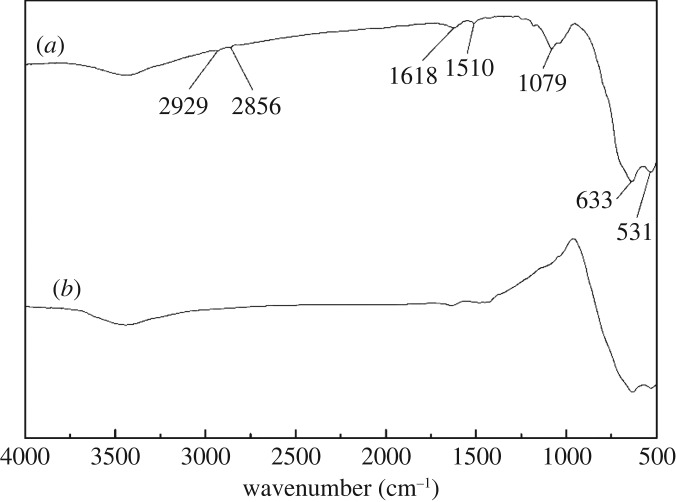
Effect of Fe3+ on the adsorption of OHA on cassiterite: (a) cassiterite conditioned in OHA at a pH of 9.0; (b) cassiterite conditioned in Fe3+ and OHA.